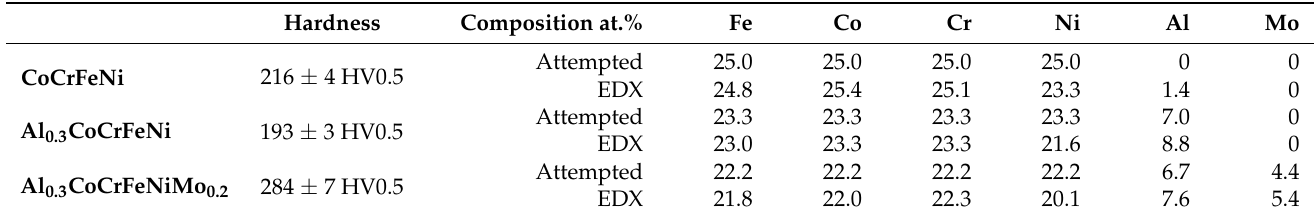
Table 1. Comparison between attempted and EDX-measured compositions in atomic percentage (region of 100 × 100 µ m 2 ) of the three MPEAs investigated. EDX compositions are to be used as an approximation.